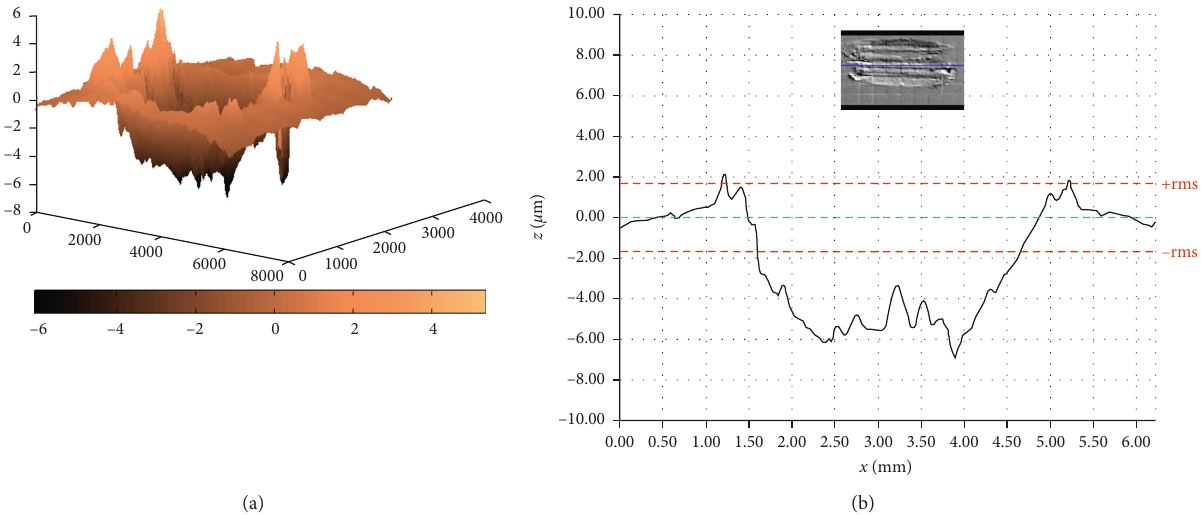
Figure 11: Three-dimensional image of the disk track of steel 2 tested at 40 ° C (a). The maximum profile depth (7 µ m) (b).